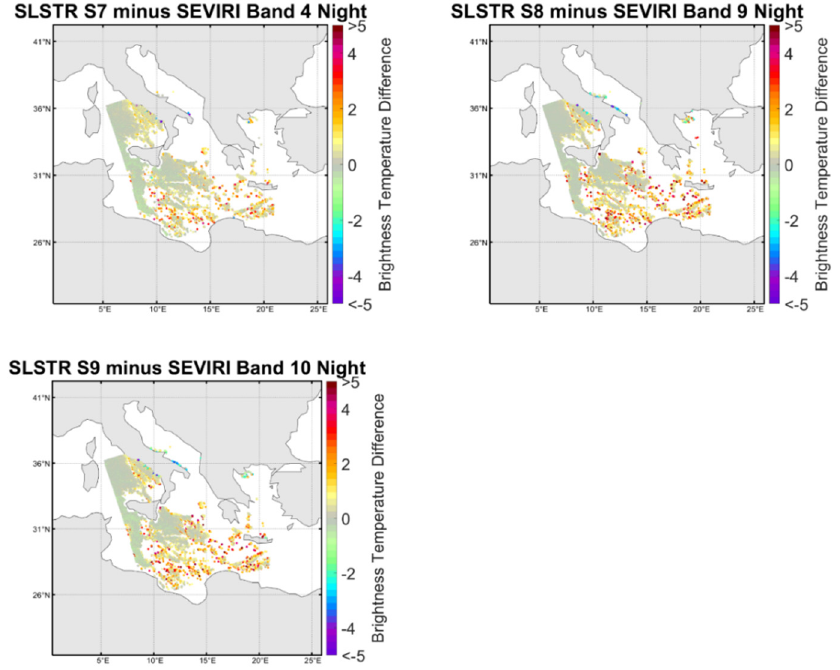
Figure 12. ( a ): SLSTR nighttime false color infrared image of the Mediterranean Sea region on 23 December 2019, 20:21:51 UTC. ( b ): Solar zenith angles at the same time. ( c ): Corresponding SLSTR satellite zenith angles. ( d ): Corresponding SEVIRI satellite zenith angles, only the points with available SEVIRI matched up pairs are